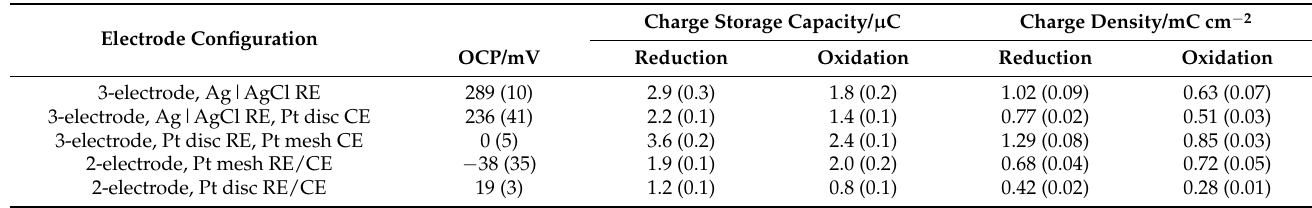
Table 1. Open circuit potential, charge storage capacity, and charge density of a 0.6 mm diameter platinum electrode in different configurations over a potential range of 0.8 to − 0.8 V at a scan rate of 100 mV s − 1 *.